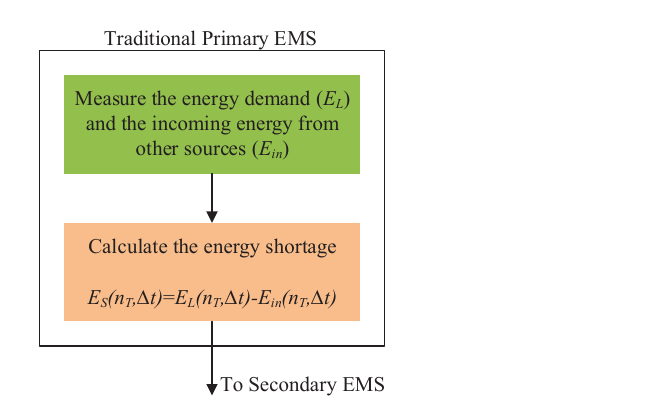
Figure 2. Energy information flow within a primary traditional EMS, as well as from the traditional to the secondary